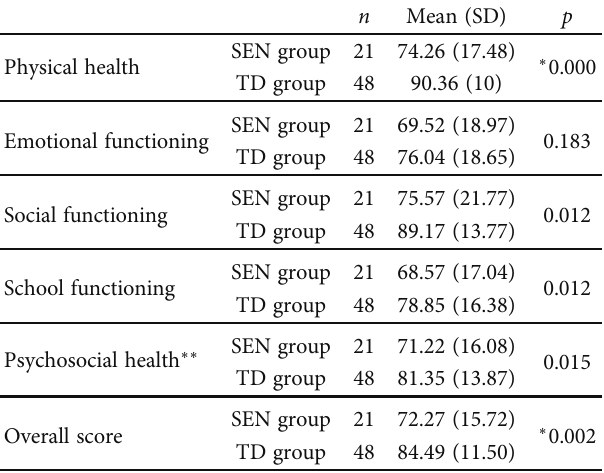
Table 4: Comparison of PedsQL between children with SEN and